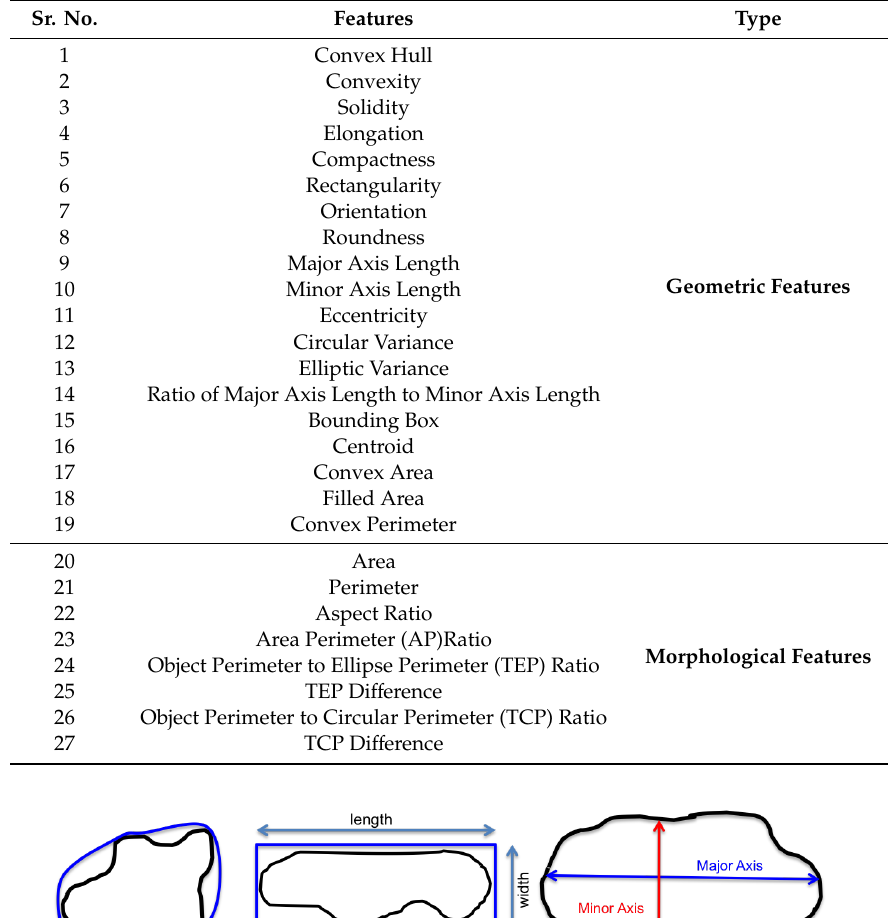
Table 1. Overview of 27 extracted geometric and morphological (G-M) features.